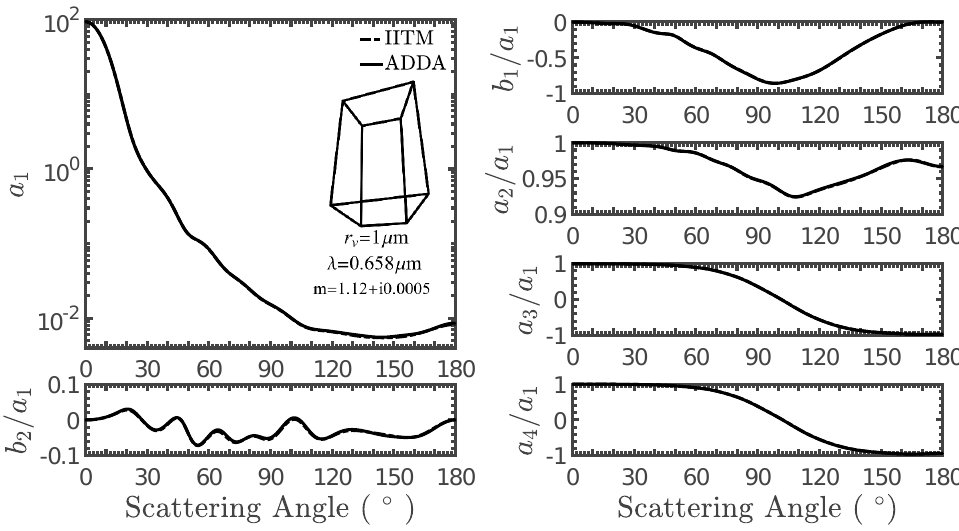
Figure 3. Comparisons of Mueller matrix elements of a hexahedron particle calculated by the invariant-imbedding T-matrix method (IITM) and the ADDA. The volume equivalent sphere radius is 1µm and the incident wavelength is 0.658 µm. The relative refractive index is 1.12 + i0.0005.